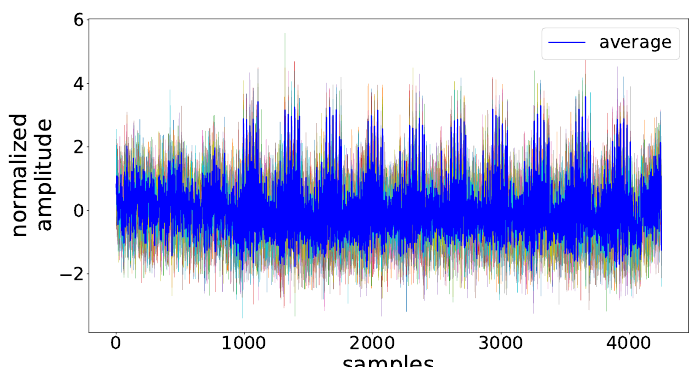
Figure 19: 10 · 500 traces and their average, at 60 m in an office environment. The AES-128 encryption is still clearly